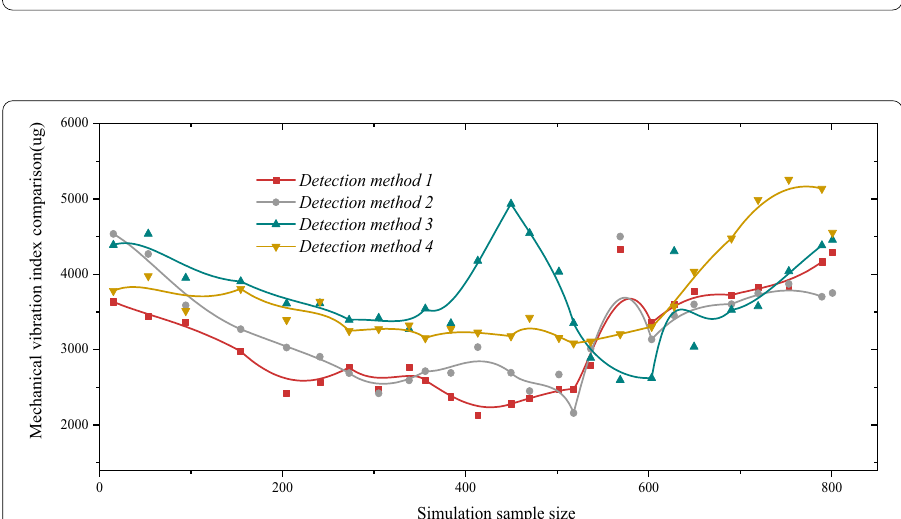
Fig. 8 Comparison of the quality of the original signal and the reconstructed signal with a compression rate of